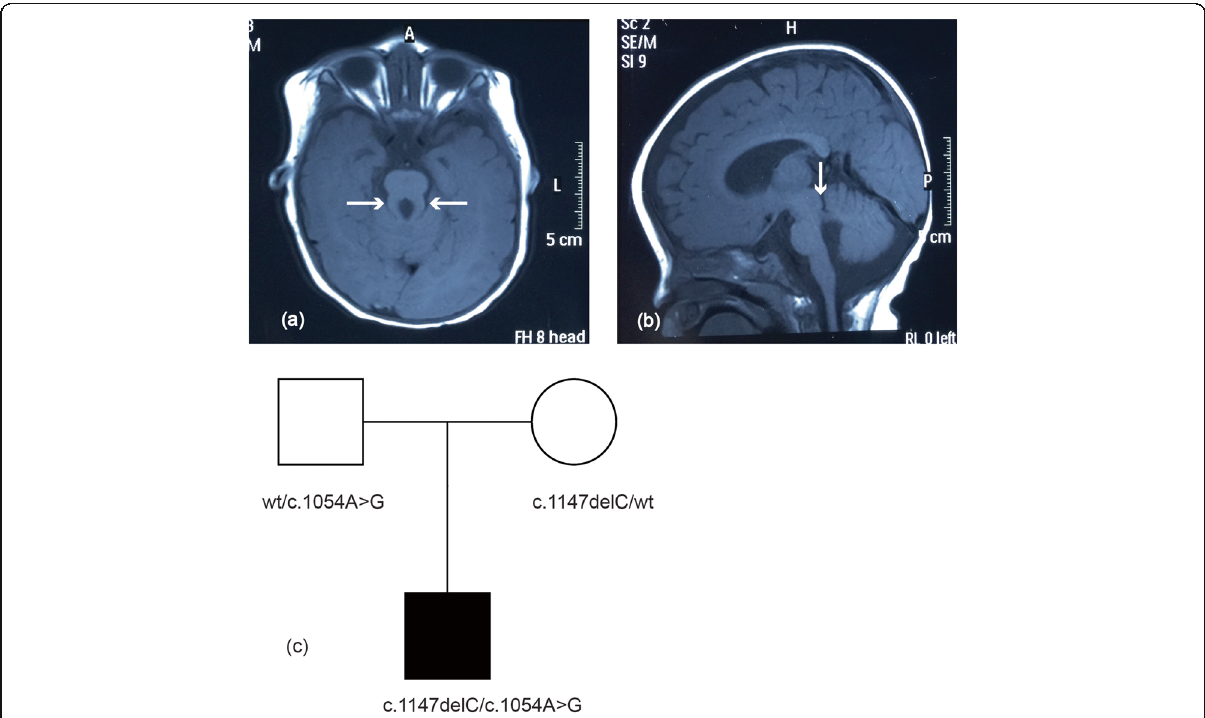
Fig. 1 Brain magnetic resonance imaging (MRI) findings for the Joubert syndrome individual. Molar tooth sign with moderate cerebellar vermis hyoplasia, lengthening and thickening of superior cerebellar peduncles as well as superior cerebellar dysplasia as indicated by white arrows. a T2- weighted image. b T1-weighted image. c Pedigree of Joubert syndrome